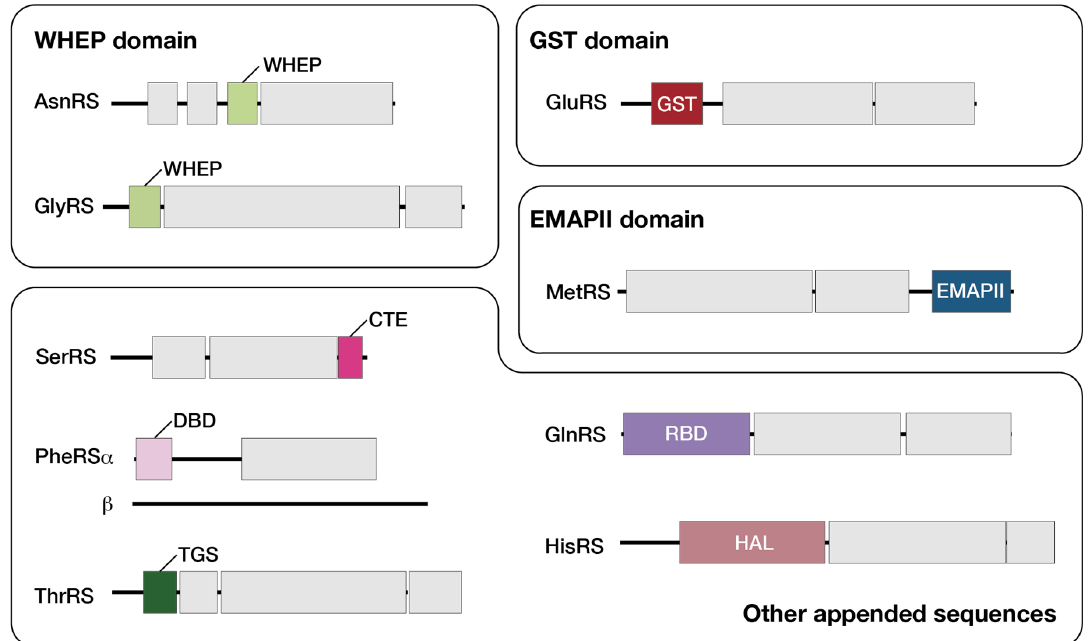
Figure 2. Characteristic domains found in Arabidopsis aaRSs. Abbreviations: CTE, the C-terminal extension; DBD, DNA binding domain; GST, glutathione S -transferase; RBD, RNA binding domain; TGS, the TGS domain named after ThrRS, GTPases, and SpoT; HAL, histidine ammonia lyase-like domain; EMAPII, endothelial monocyte activating polypeptide II domain.